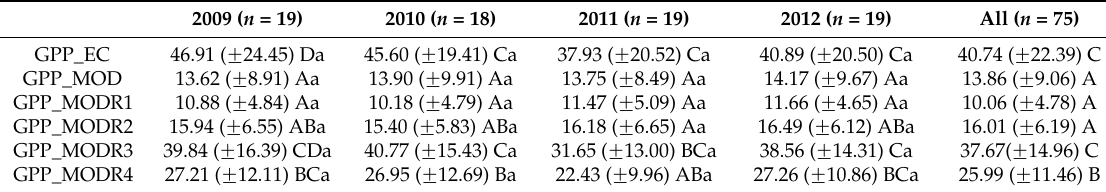
Table 2. GPP estimation differences among diverse estimation methods and inter-annual differences during growing season in different years